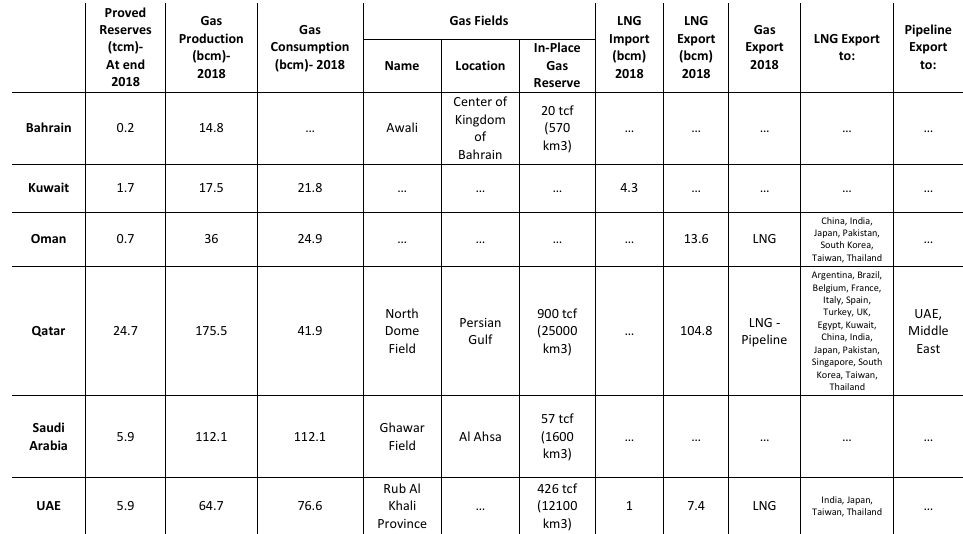
Figure 6. The GCC countries’ natural gas data in